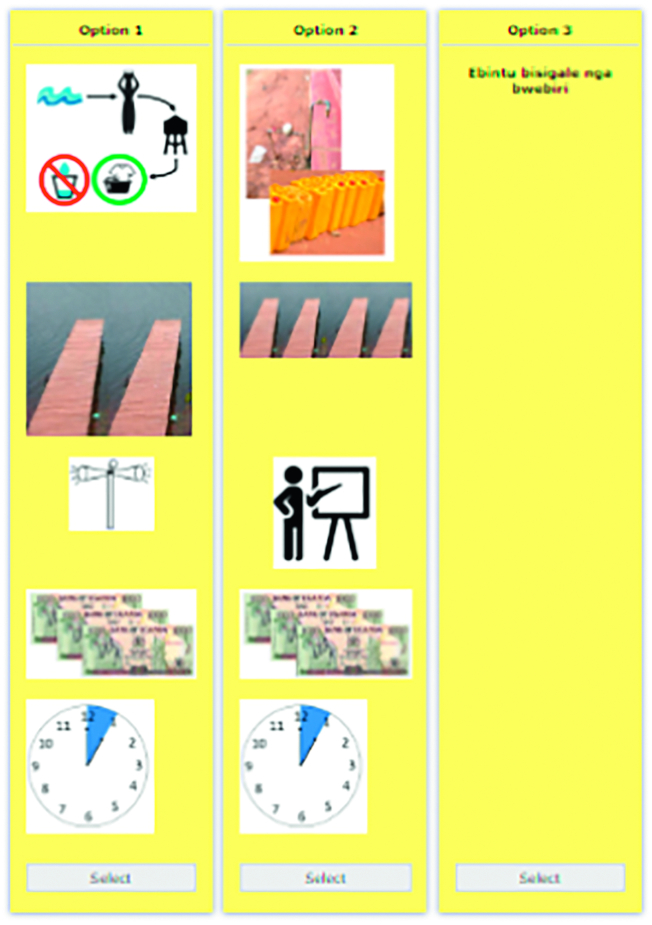
Example choice card.